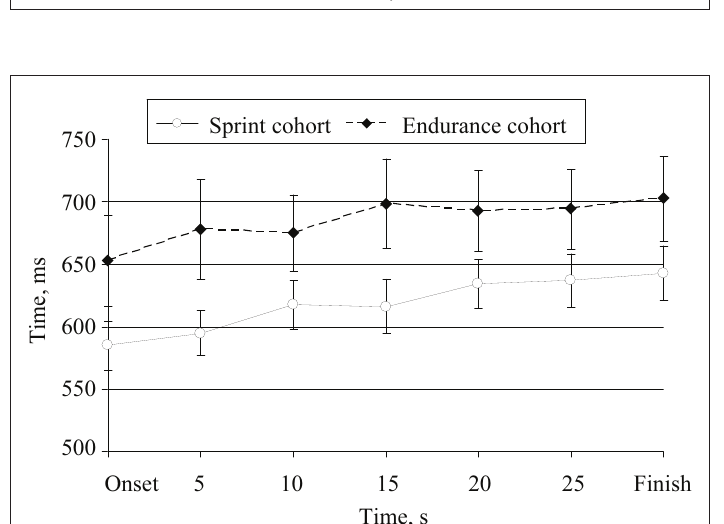
Figure 2. Dynamics of relative muscle power while performing 30-s jumps test